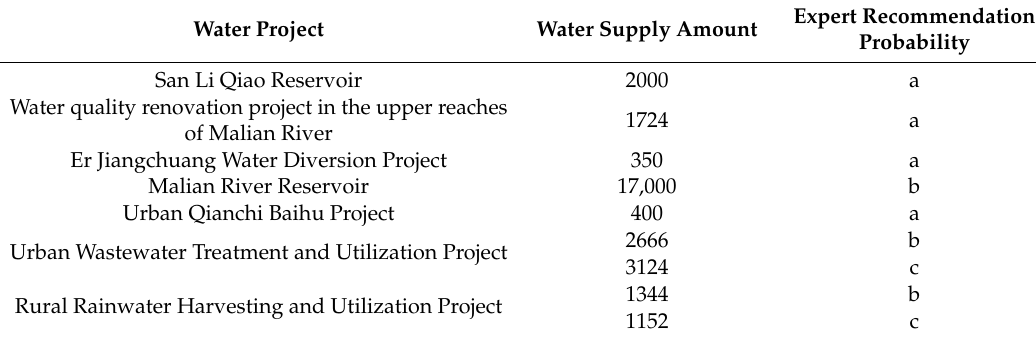
Table 5. Expert probability consultation results of water conservancy project construction plan in 2030. Very likely possible, expressed by a, is 0.8, larger possible, expressed by b, is 0.6, lesser possibility, expressed by c, is 0.4, and impossible possibility, expressed by d, is